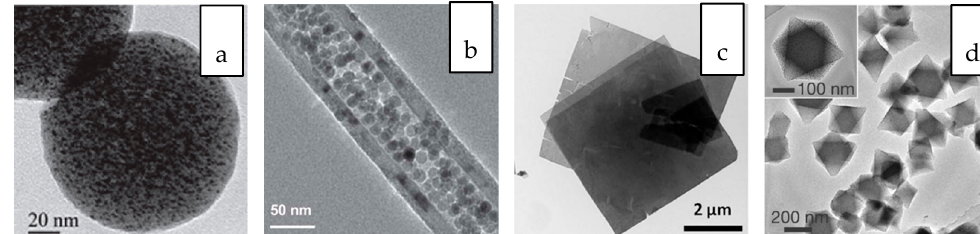
Figure 1. Representative illustrations of dimensionally different nanomaterials applied for gas separation and liquid separation nanocomposite membrane.